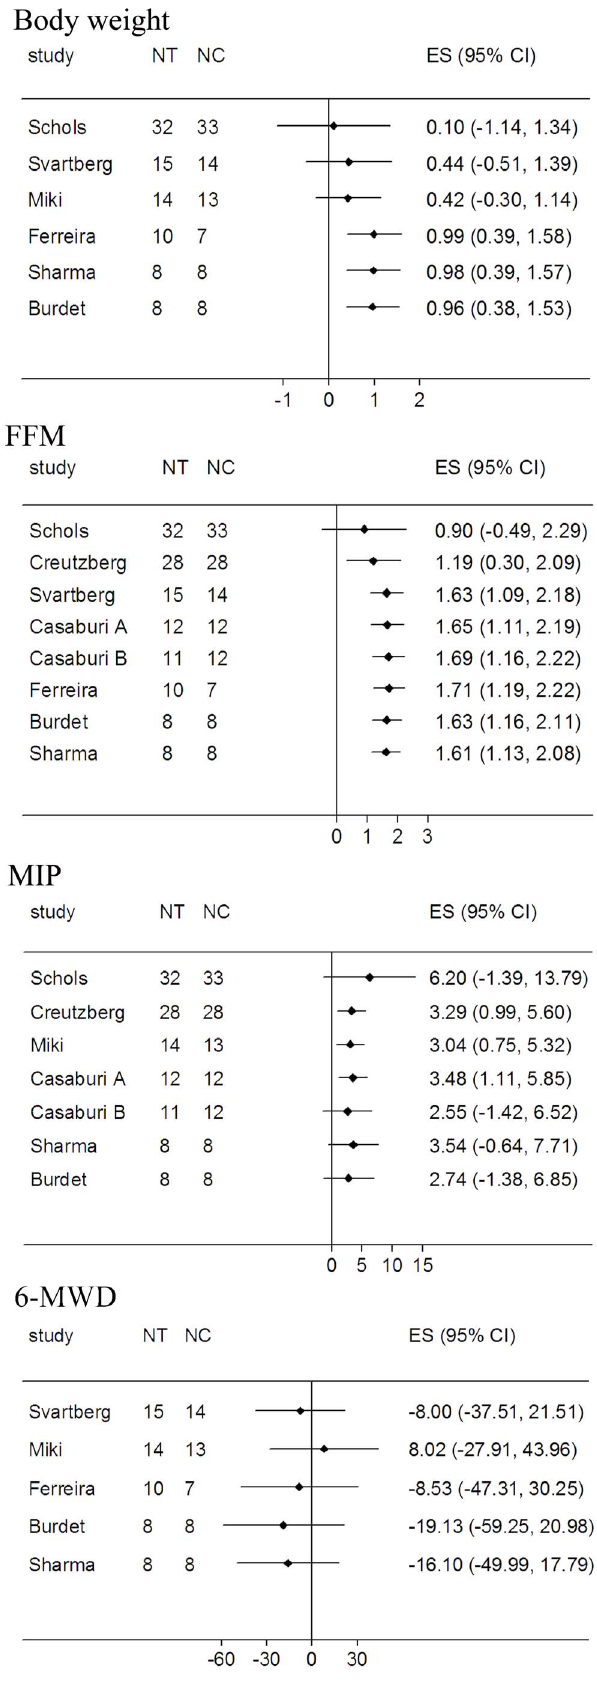
Figure 2. Cumulative meta-analysis sorted by sample size for body weight, fat-free mass (FFM), maximal inspiratory pres- sure (MIP) and six-min walk distance (6-MWD). NC=the number of control group; NT=the number of treatment